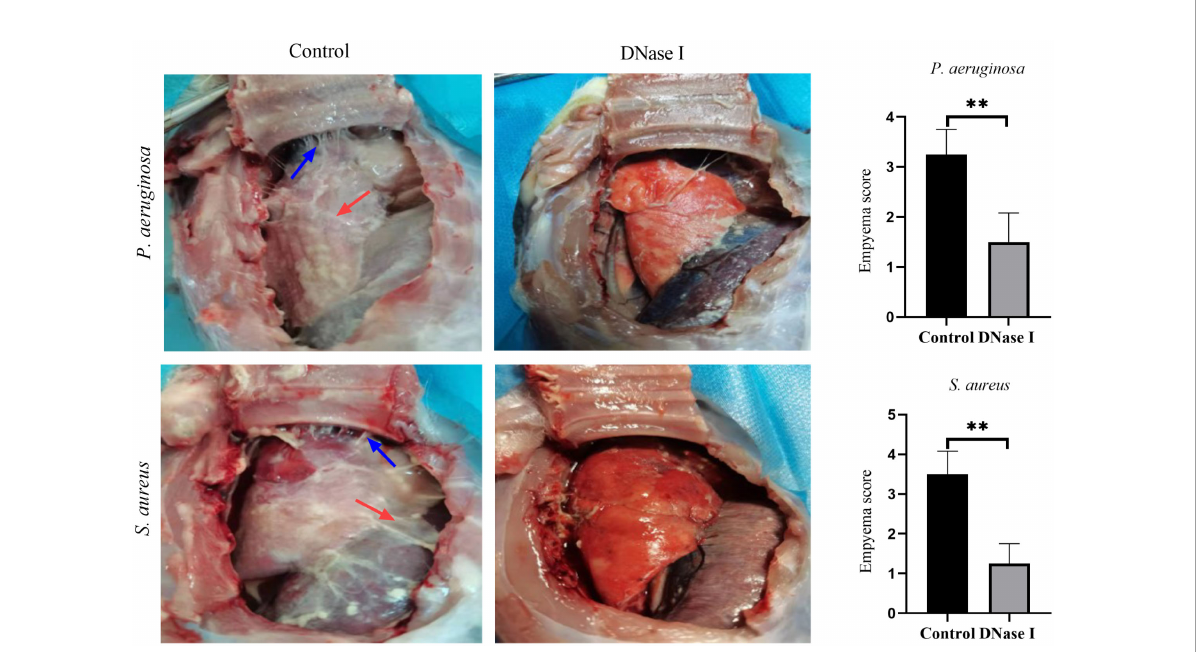
FIGURE 7 Gross pathology specimens of rabbit pleural cavities 24 h after infection and treatment. The control rabbits had more pleural adhesions and fi brin depositions between the visceral and parietal pleura than the DNase I-treated rabbits. The blue arrows indicate adhesion bands and the red arrows indicate fi brin deposition. The empyema scores are presented as mean ± SD. An asterisk indicates a signi fi cant difference; ** indicates p < 0.01, compared with the values in the drug-free control group using t -tests (n = 4).